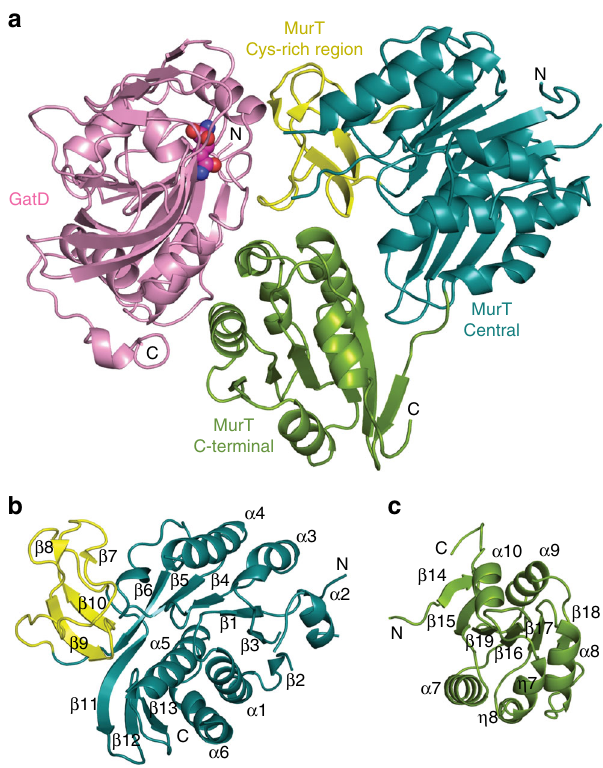
Fig. 3 Domains of MurT/GatD. Ribbon representations of a the MurT/ GatD amidotransferase complex, b the central and c the C-terminal domains of MurT. The glutamine substrate is shown as atom-colored spheres. N- and C-termini, as well as numbering of α -helices and β -strands are indicated. Domains are labeled and colored in dark cyan (central domain), green (C-terminal domains), yellow (cysteine-rich zinc-ribbon- like insertion) or pink